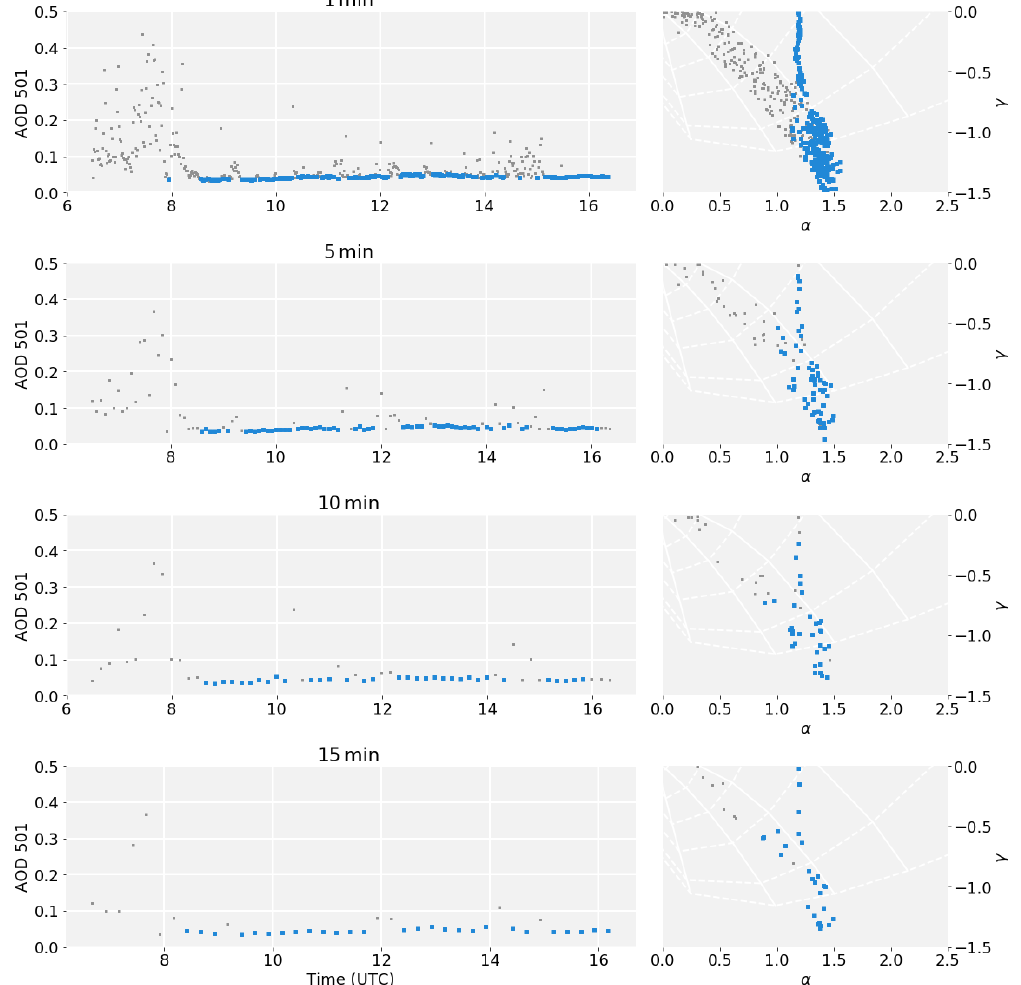
Figure A2. Time series of AOD at 501nm and α – γ plots at the original 1min resolution, as well as 5, 10, and 15min subsampling. Note that the initial data point was chosen randomly, so the 10 and 15min resolutions are not a further subset of the 5min resolution. Grey squares indicate cloudy points and blue clear ones. The cloud detection threshold was set to 0.019, 0.027, and 0.042 for the lower time